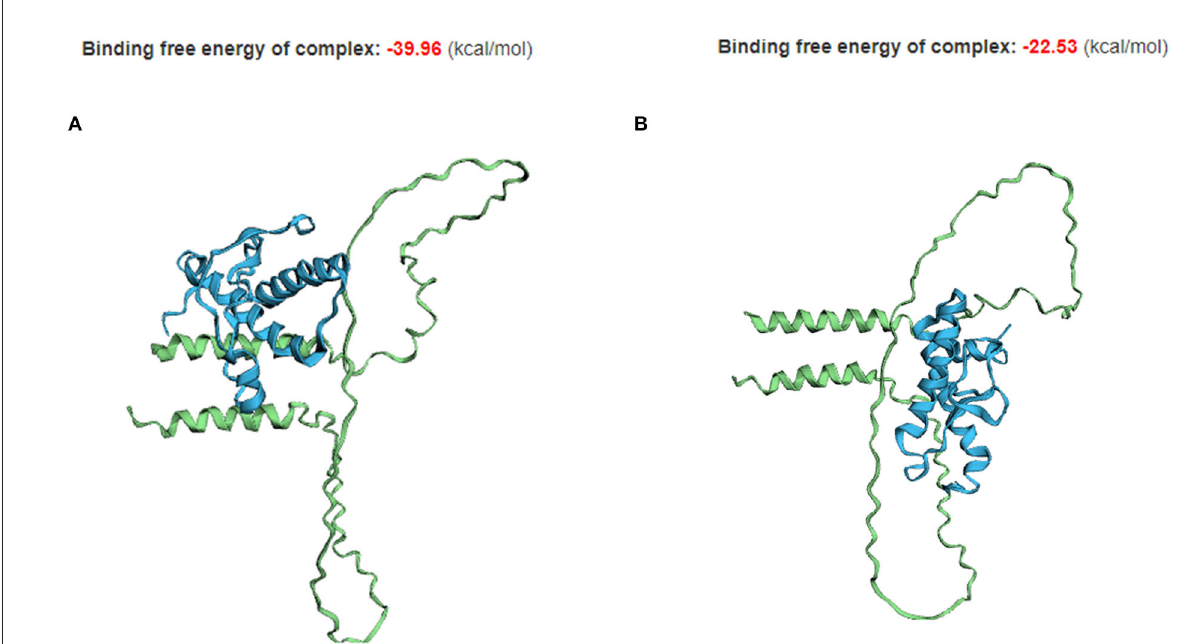
FIGURE5 The tertiary structure and protein–protein interaction of canine PrP with canine Sho carrying the wild-type and 70_71DelAA allele. (A) Canine PrP interaction with canine Sho carrying the wild-type allele. (B) Canine PrP interaction with canine Sho carrying the 70_71DelAA allele. The blue structure indicates canine PrP. The green structure indicates canine